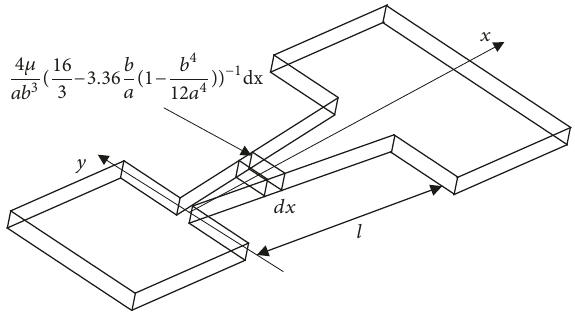
Figure 15: Calculation of cone tube’s flow resistance.